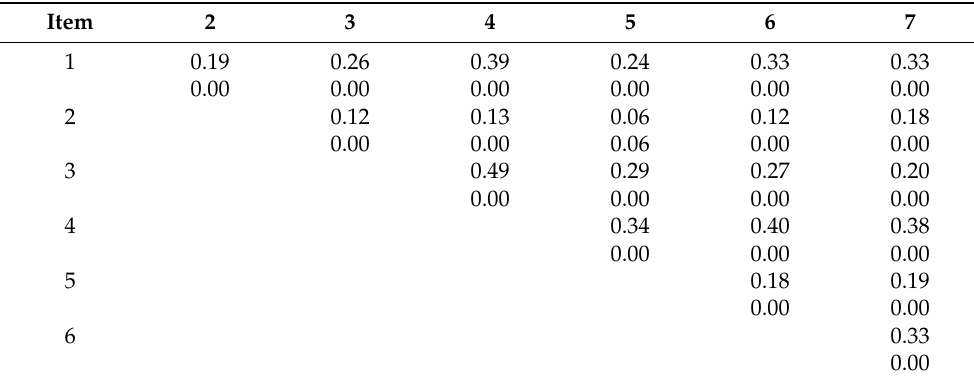
Table 1. Inter-item correlations using Kendall’s tau b